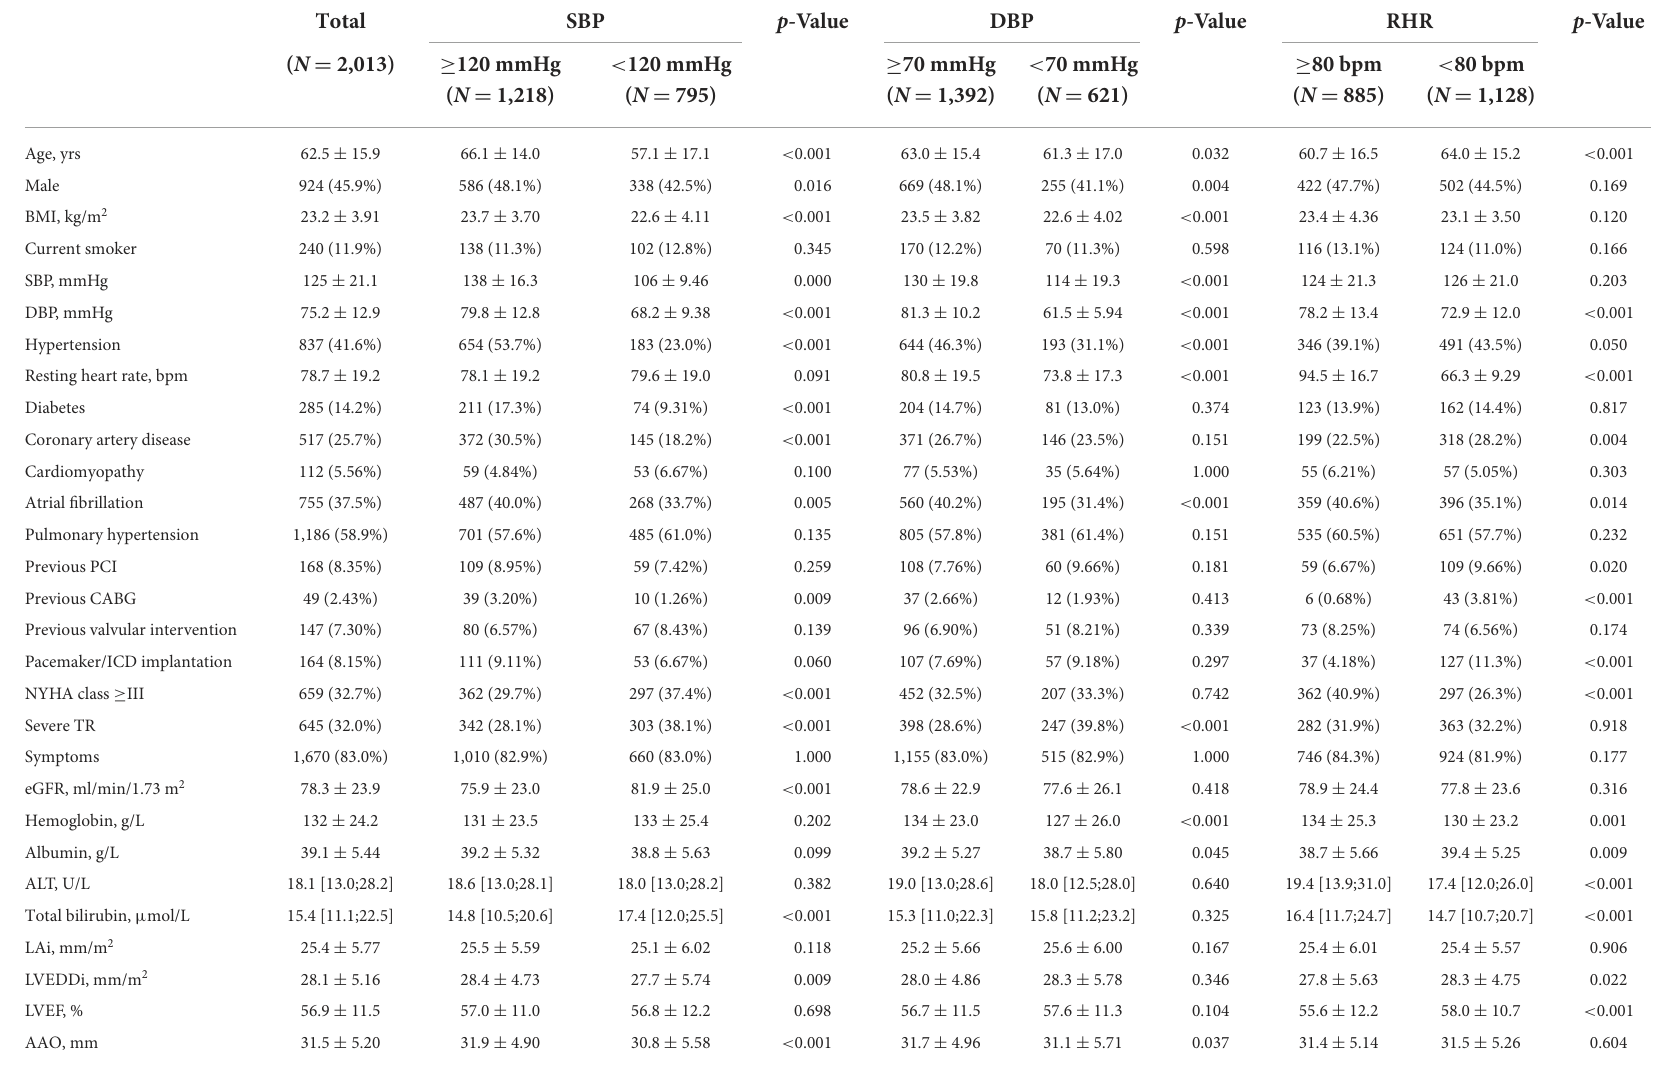
TABLE 1 Baseline characteristics of the study